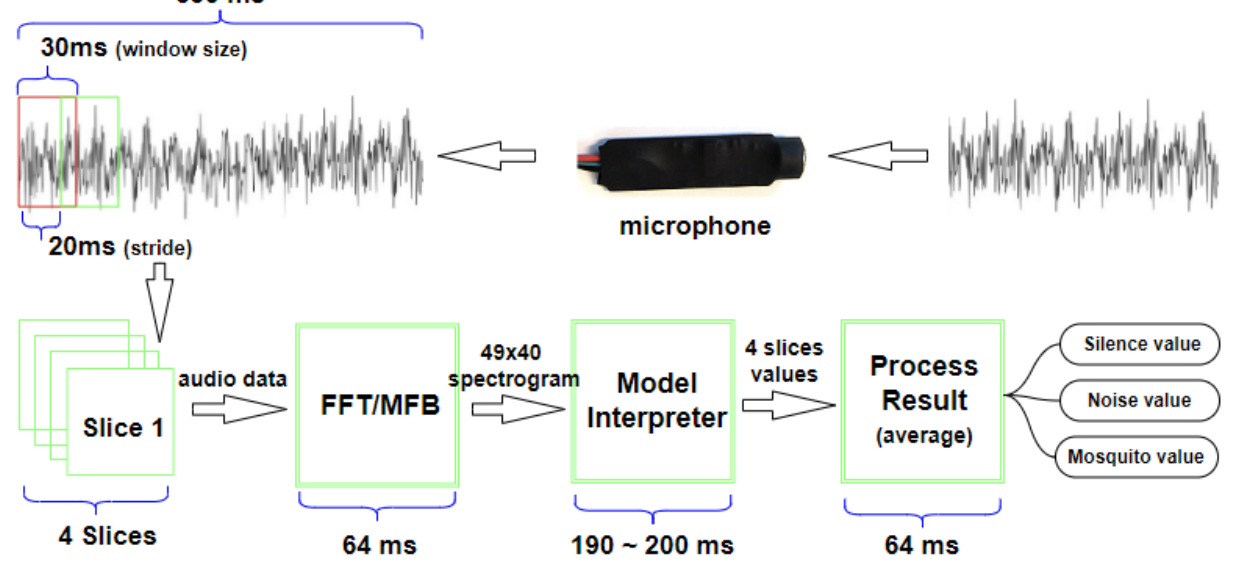
Figure 5. A classification result is produced for every 330 ms audio segment from